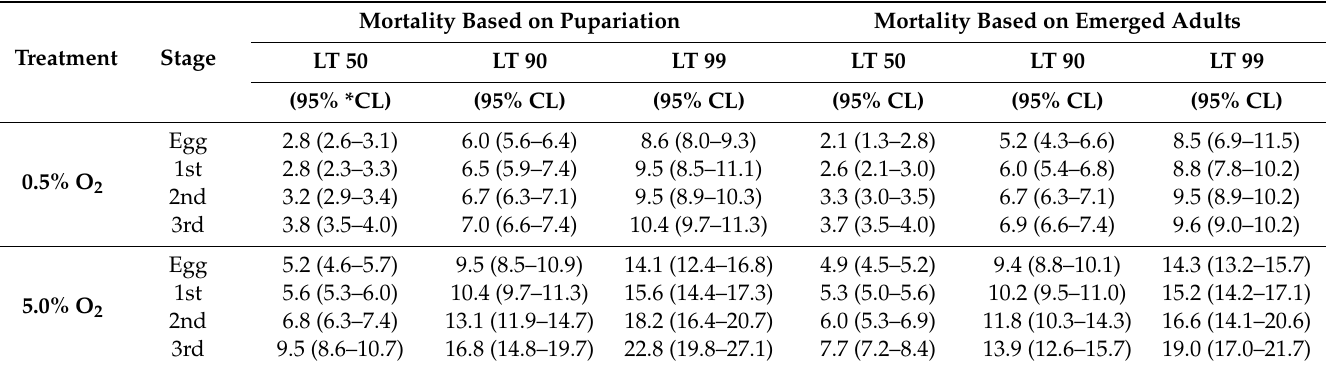
Table 1. Low-oxygen treatment duration to induce 50, 90 and 99% mortality based on pupariation and emerged adults from four developmental stages of C. capitata